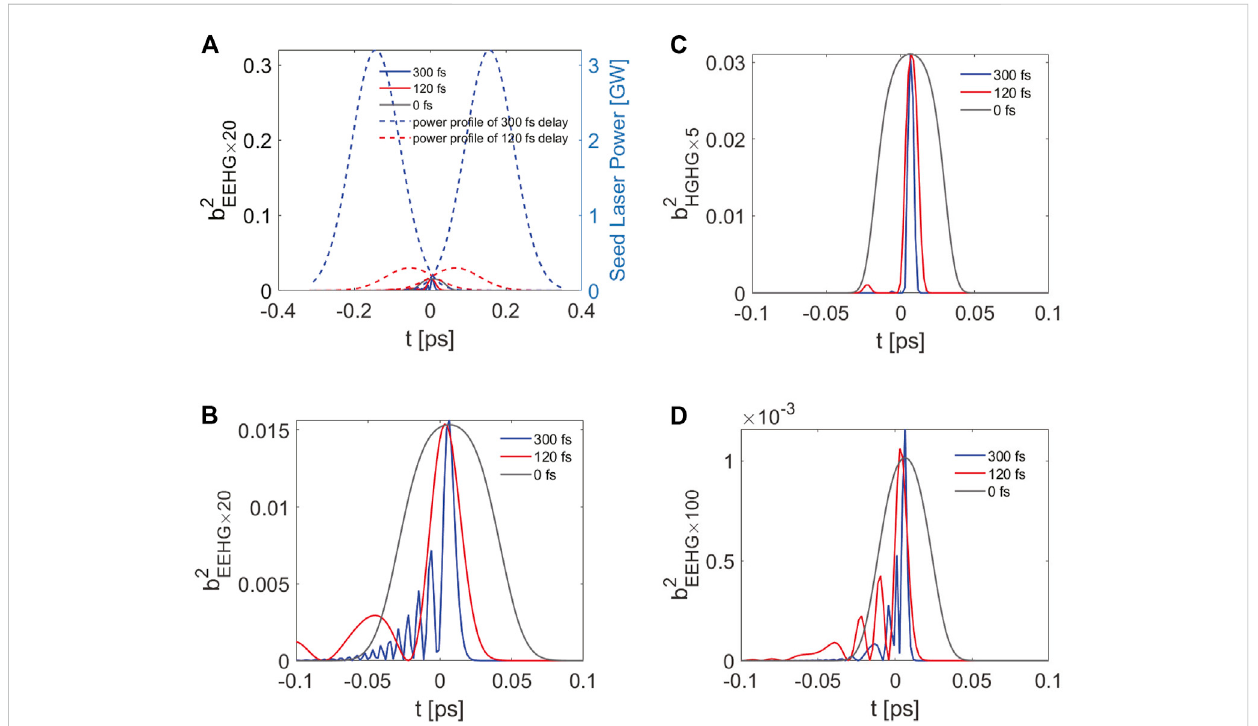
FIGURE 2 (A) Squared bunching factors of the cascaded scheme at the entrance of RAD1 with different time delays and the corresponding power pro fi les of the seed lasers. (B) Zoomed bunching factors of Figure 2A. (C) Squared bunching factors of the cascade scheme at the entrance of RAD2 with different relative time delays of the two seed lasers. (D) Squared bunching factors of the single-stage EEHG scheme at the entrance of the radiator with different relative time delays of the two seed